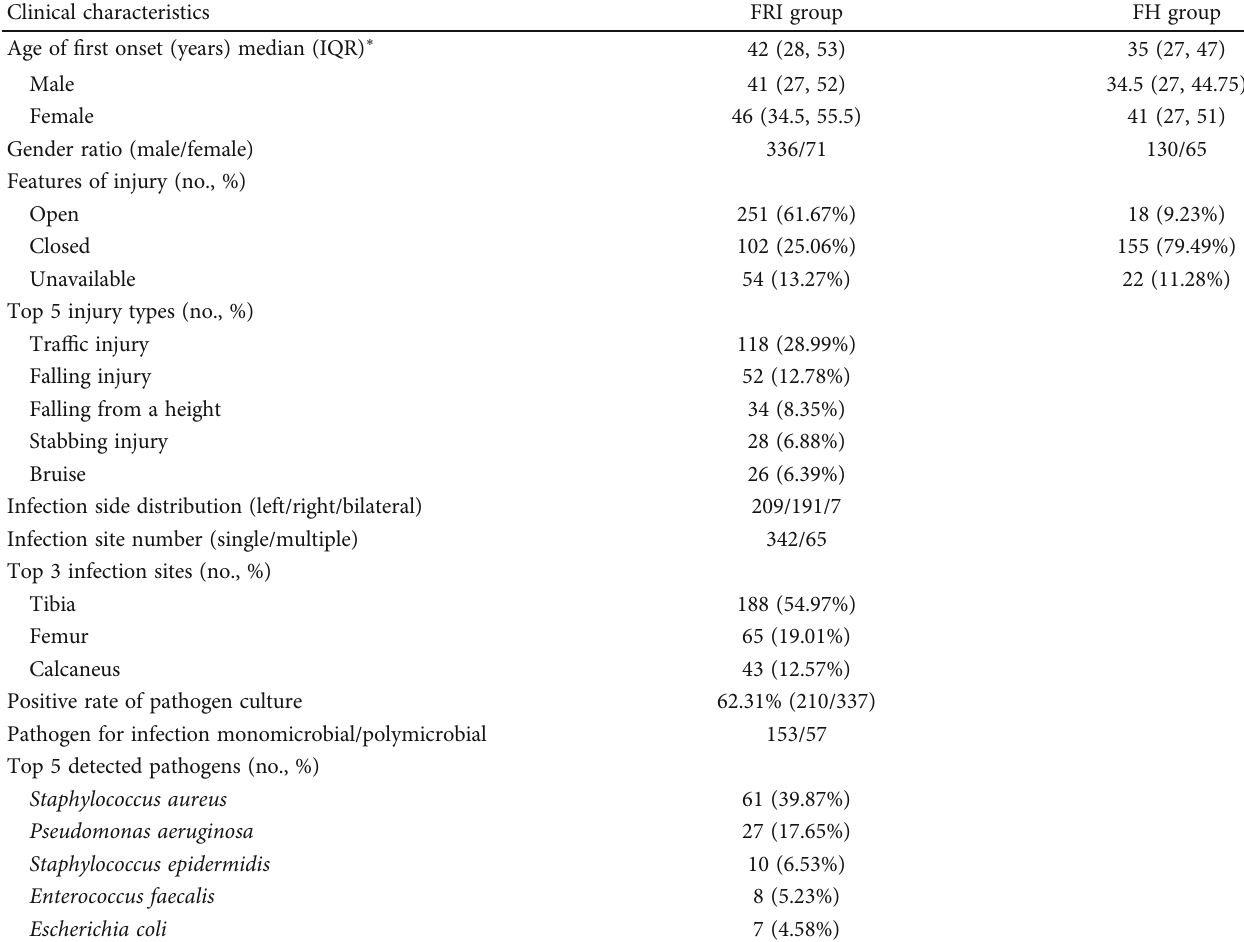
Table 2: Demographics and clinical characteristics of 407 FRI patients and 195 FH patients.